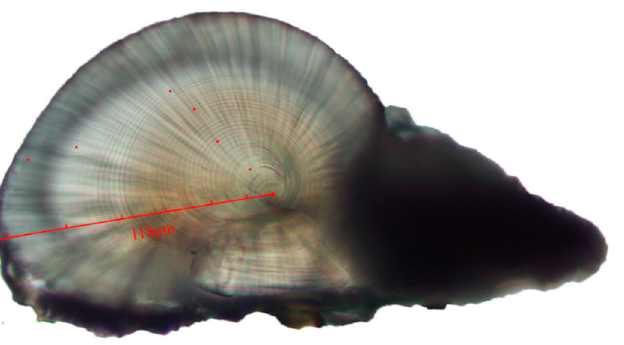
Figure 2. Ring counts and measurements of S. oualaniensis statoliths. This sample was collected in September, and was a female S. oualaniensis with a mantle length of 9.8 cm, a body weight of 29.39 g and an age of 62 days. The distance from the core to the longest edge was 118 μ m.